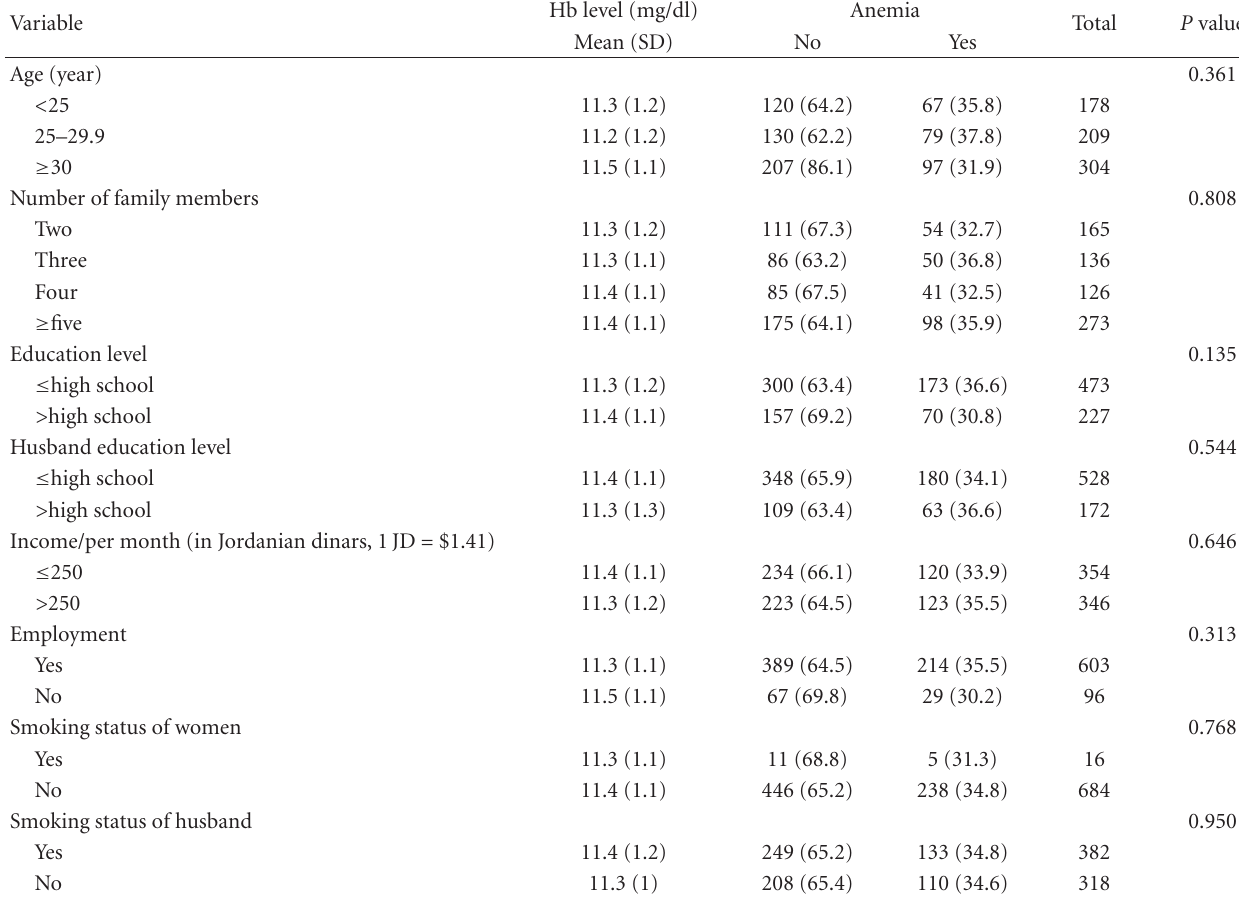
Table 2: Prevalence of anemia according to sociodemographic